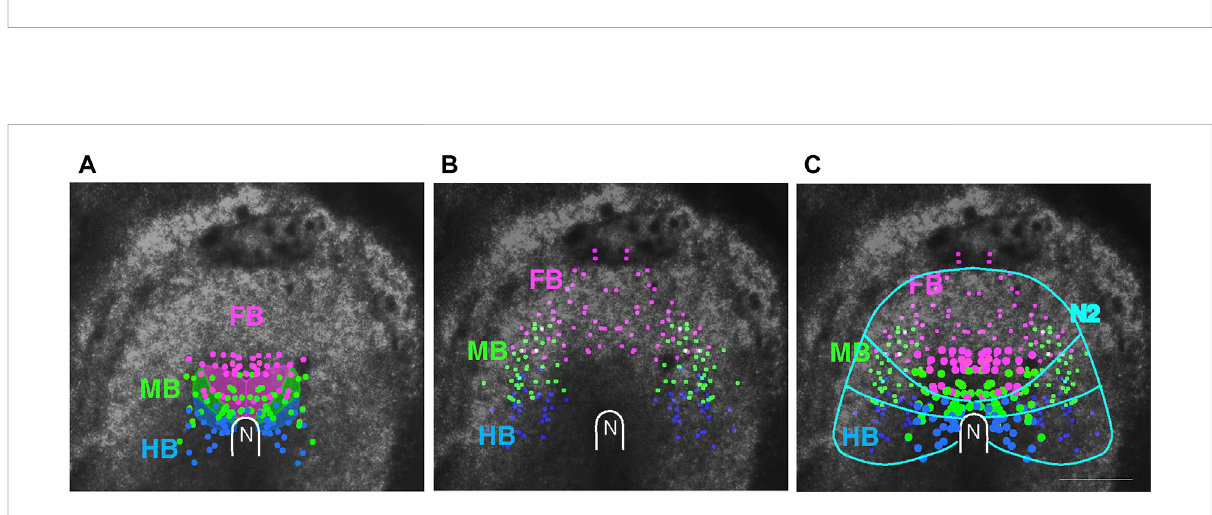
FIGURE 2 Long – range axial convergence of sparsely EGFP-labeled anterior epiblast cells. (A) Snapshots of an EGFP – labeled chicken embryo at different developmental stages; excerpt frames taken from Supplementary Movie S2. (B) Trajectories of EGFP-labeled cells were drawn in random colors to distinguish individual lines during st. 5 – 8 of the same embryo, taken from Supplementary Movie S3. Broken ovals indicate the cell trajectories showing cell migration across the area pellucida/area opaca boundary. Scale bars, 1 mm. Adopted from Figure 1A of Yoshihi et al. (2022).